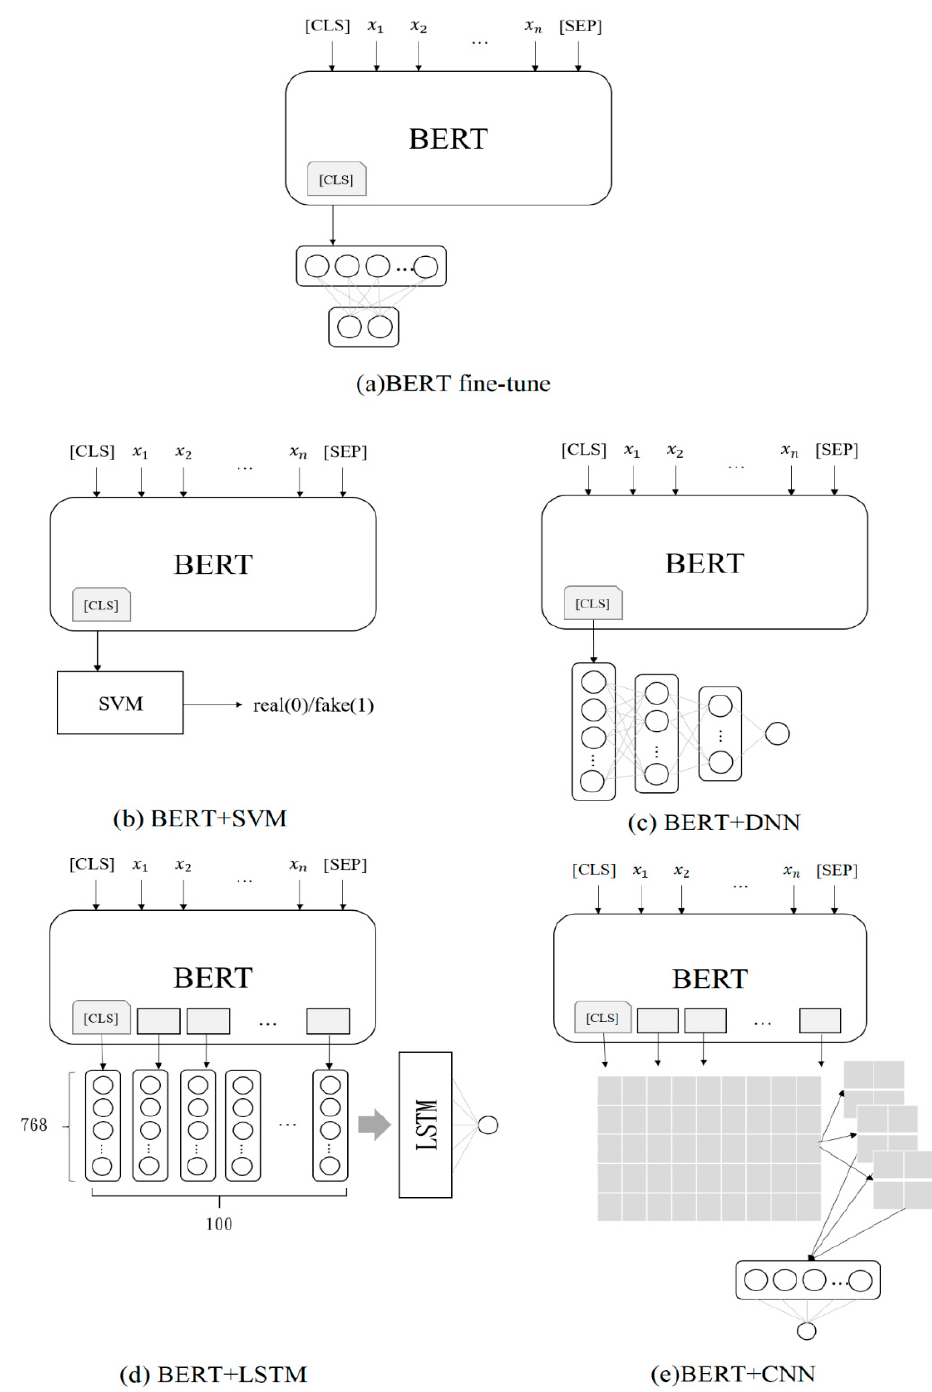
Figure 7. BERT classification models.